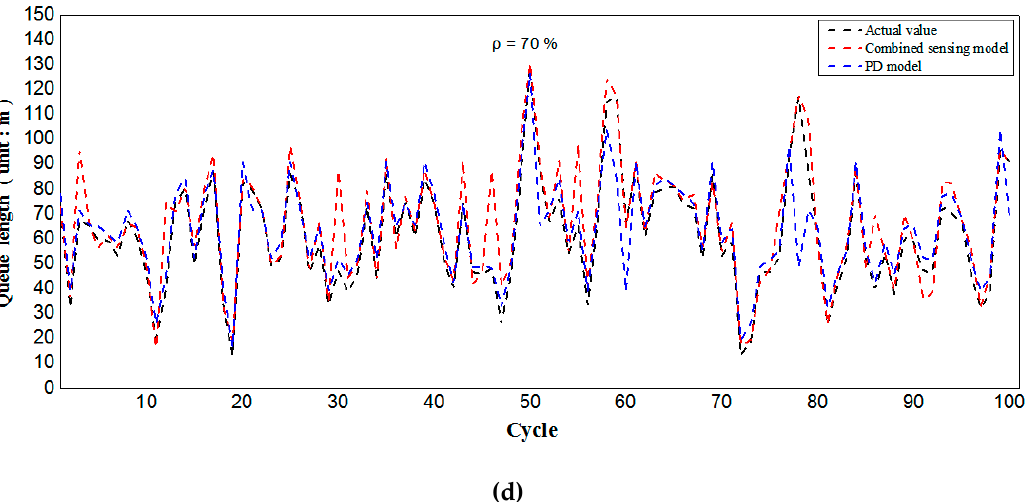
Figure 11. Comparison of queue length at 10% penetration rate ( a ) and comparison of queue length at 30% penetration rate ( b ) and comparison of queue length at 50% penetration rate ( c ) and comparison of queue length at 70% penetration rate ( d ) .